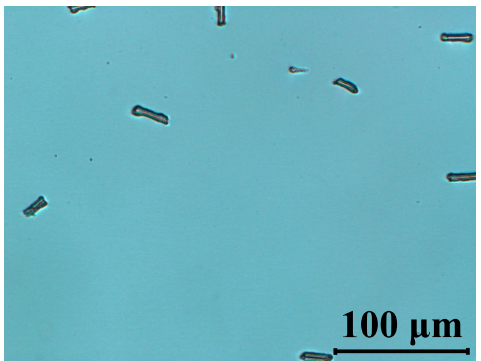
Figure 7. Polarized optical micrographs of cells filled with 5005 mixture observed between crossed polarizers under blue light ( λ = 445 nm, P = 40 mW/cm 2 , t =120 min). The LC’s optical axis was rotated at 45° with respect to polarizer orientation.